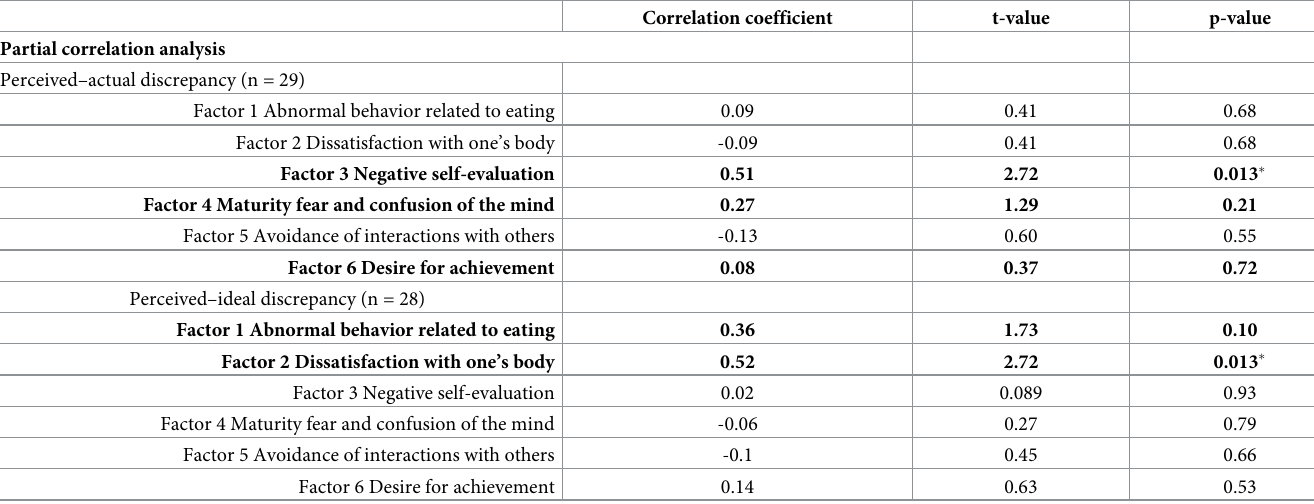
Table 3. Relationships between body-image disturbance components and EDI2 factors, after controlling for potential confounders (e.g.,